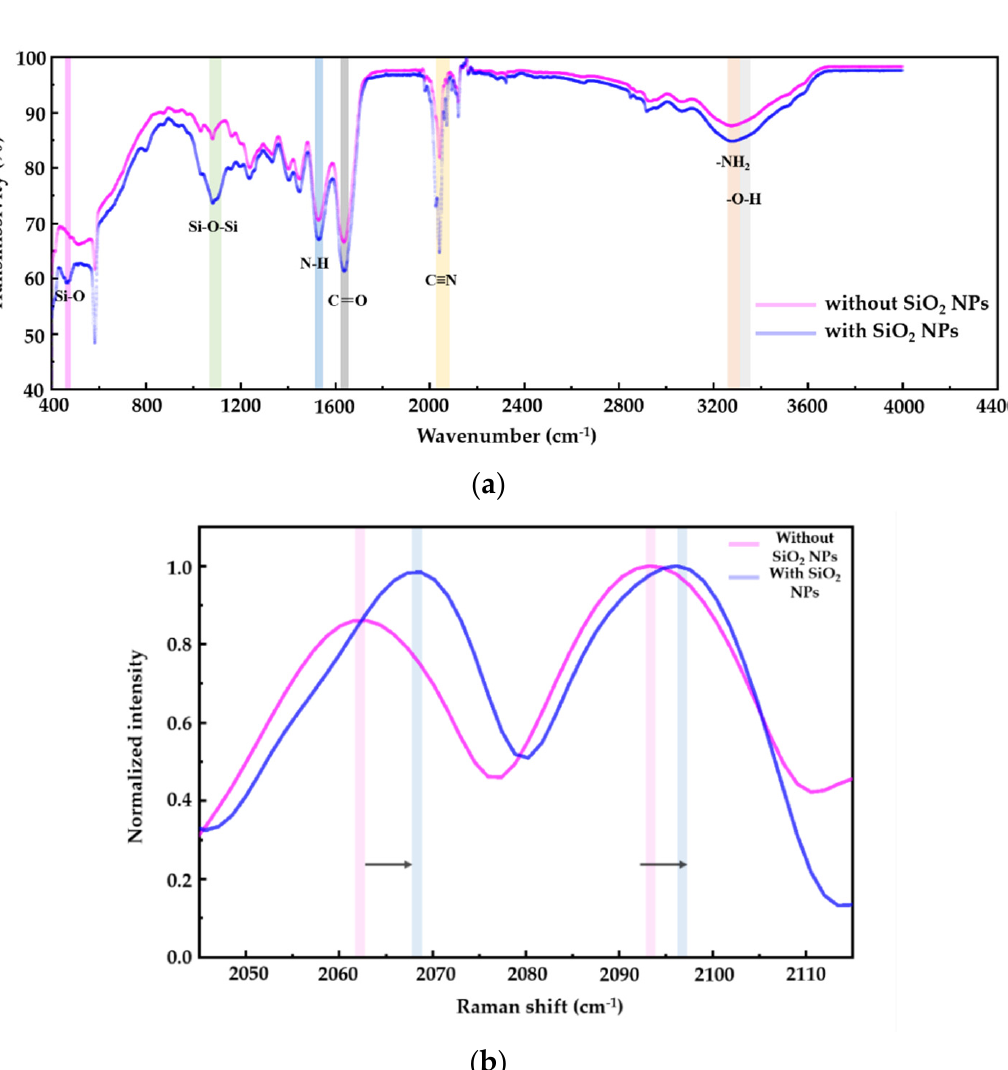
Figure 6. ( a ) Fourier transform infrared (FTIR) spectrum of the iTEG with/without SiO 2 NPs; ( b ) Raman spectrum of the iTEG with/without SiO 2 NPs.